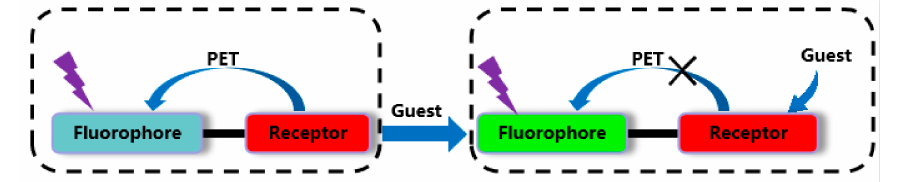
Figure 5. Working mechanism of the PET fluorescent molecular